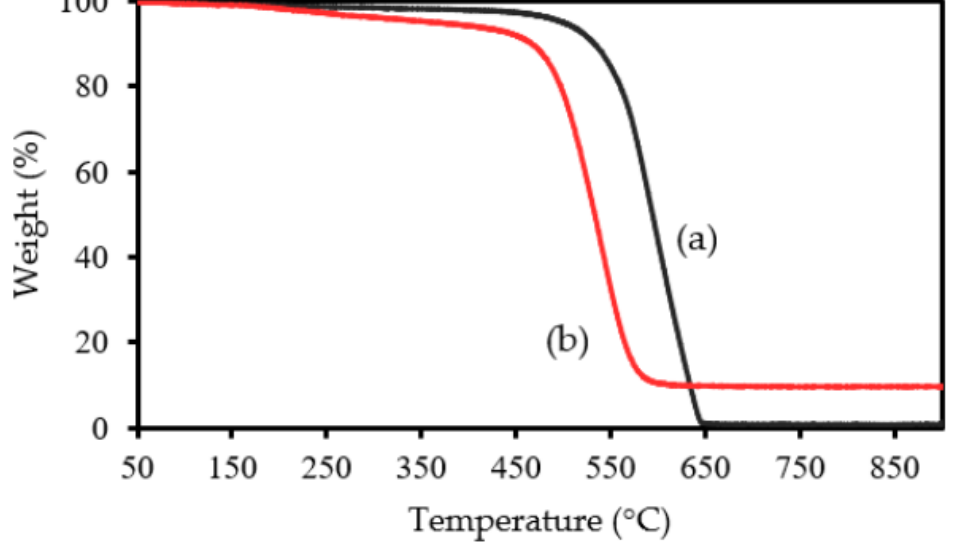
Figure 2. TG analysis of CX-4 (a) before and (b) after ASNase immobilization. The degree of disorder in the carbonaceous matrix following enzyme